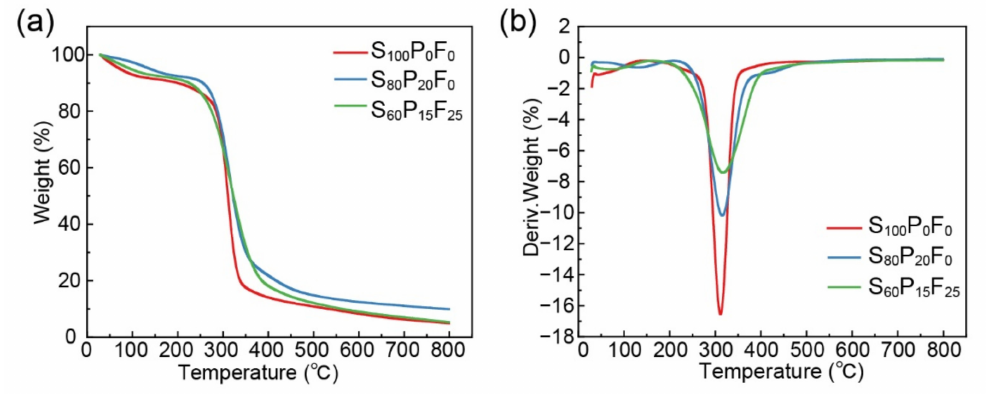
Figure 4. ( a ) TGA and ( b ) DTG curves of different SPF